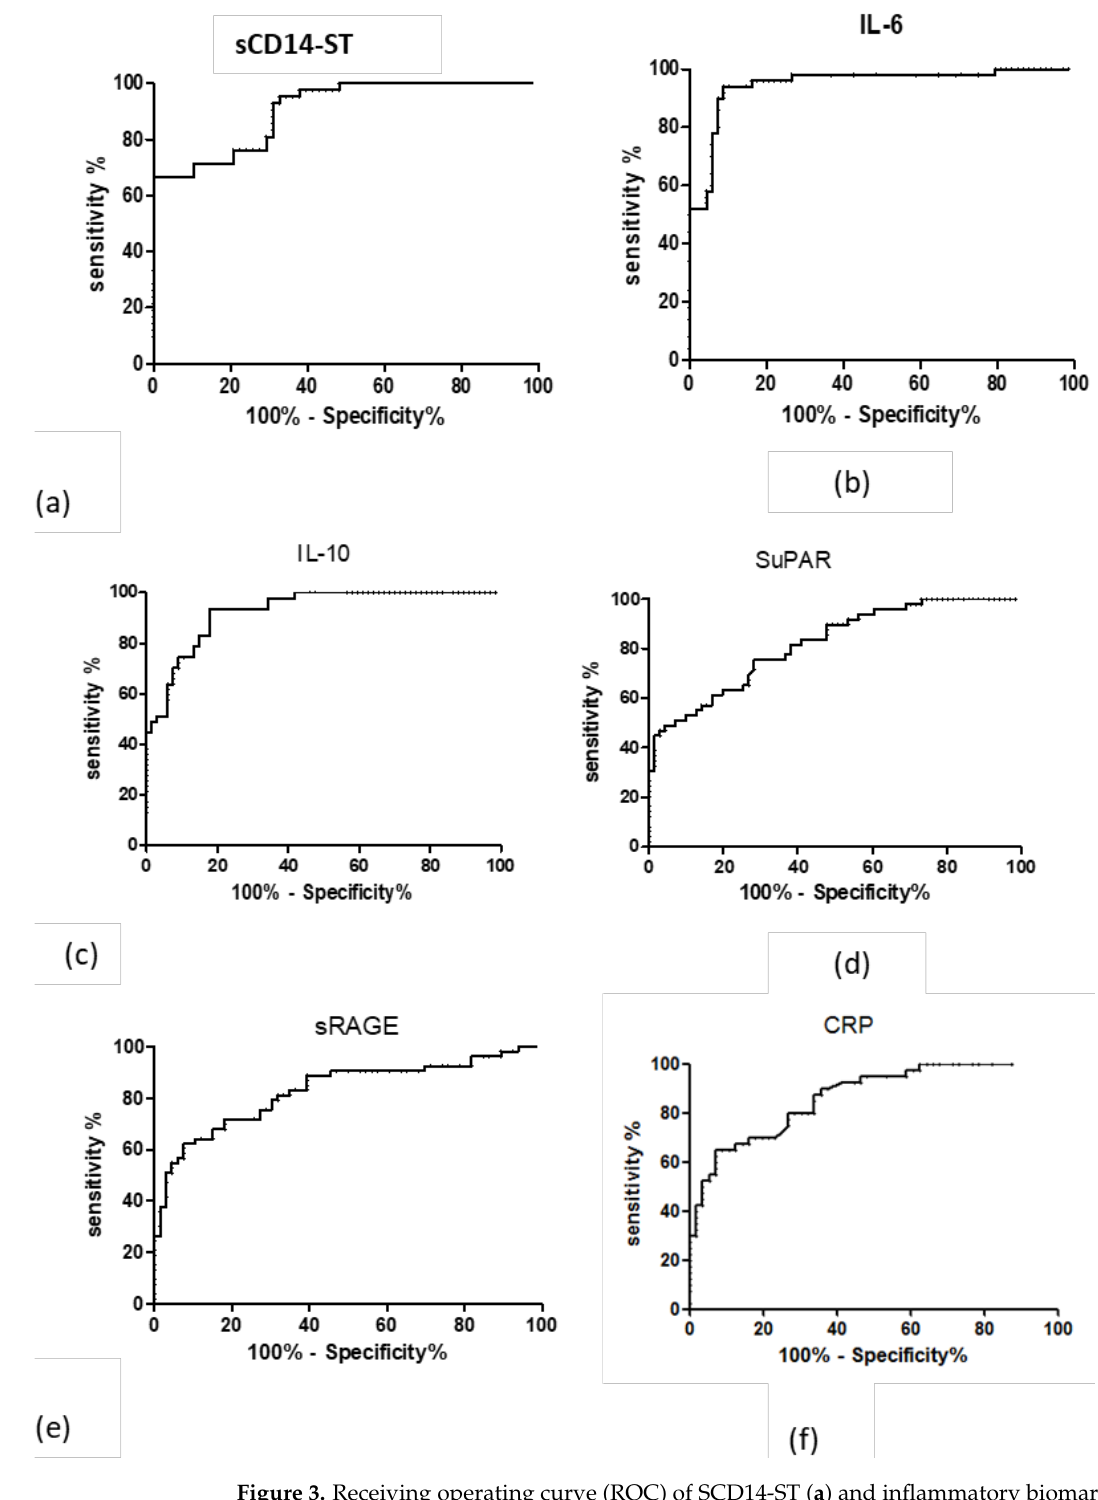
Figure 3. Receiving operating curve (ROC) of SCD14-ST ( a ) and inflammatory biomarkers IL-6 ( b ) IL-10 ( c ) SuPAR ( d ) sRAGE ( e ), CRP: C-reactive protein ( f ).